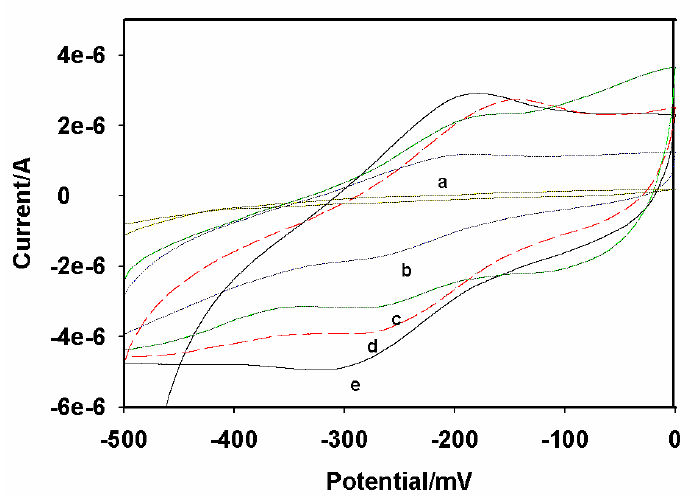
Figure 5. CV’s of (a) bare GCE; (b) GCE|PTH|; (c) GCE|AuNP|PTH|AFB conjugate|HRP-blocked; (d) GCE|AuNP|PTH|AFB (e) GCE|AuNP|PTH. Conditions: acetate buffer ph 6.5; scan rate = 10